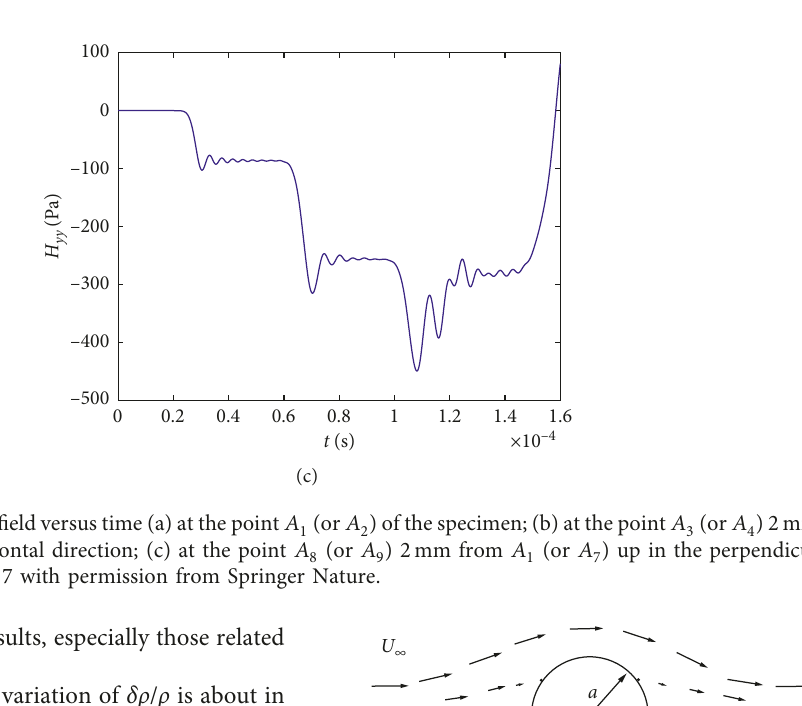
(or A ) 2mm from A (or 3 4 1 (or A ) up in the perpendicular direction, 1 7